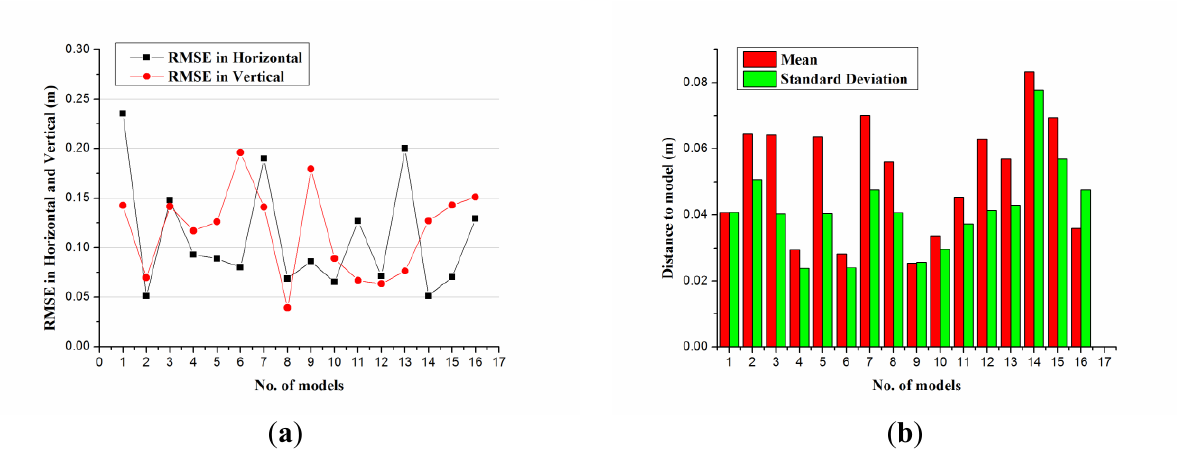
Figure 14. Accuracy assessment of the proposed method. ( a ) RMSE of the reconstructed building model in the horizontal and vertical directions; and ( b ) mean and standard deviation of the distances from the LiDAR point clouds to the reconstructed building